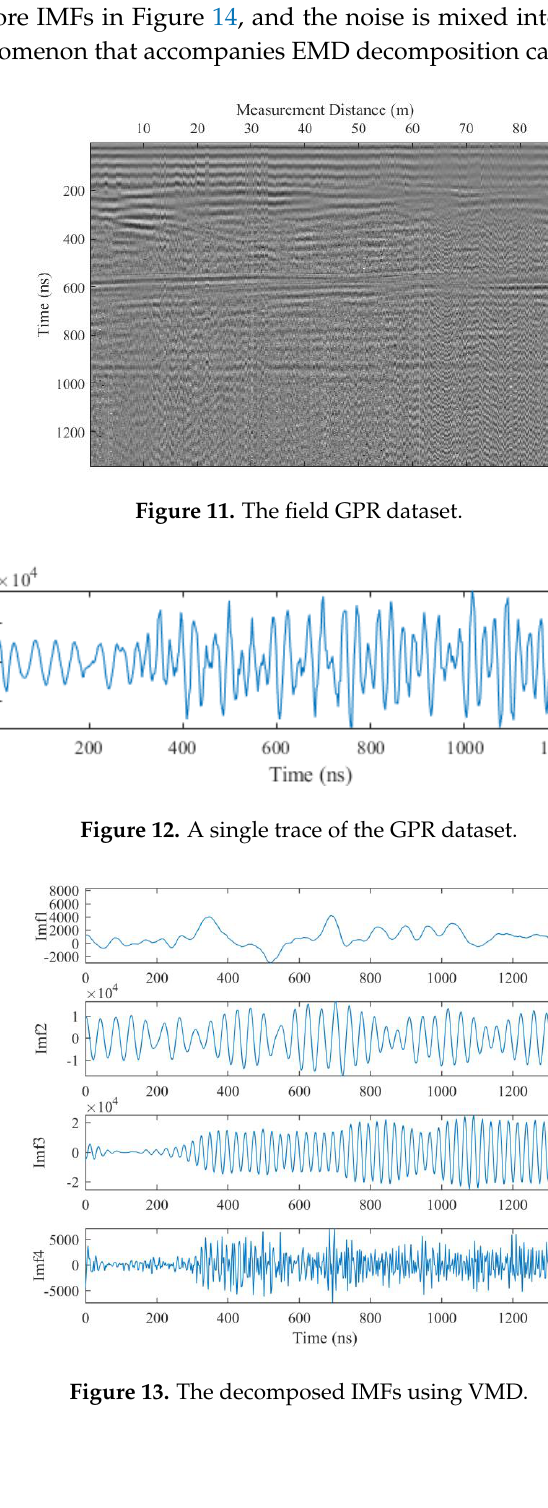
Figure 14. The decomposed IMFs using EMD.